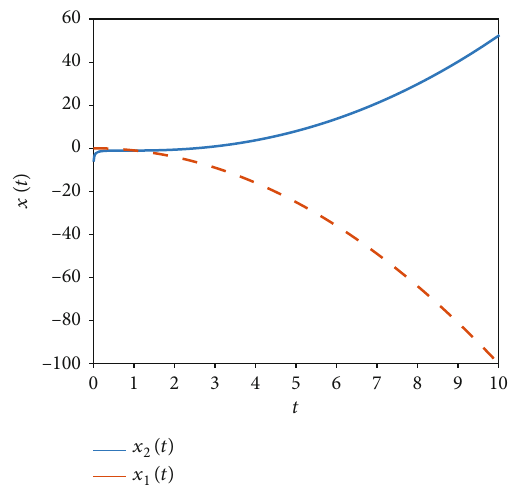
Figure 2: Curves of x ð t Þ in Example